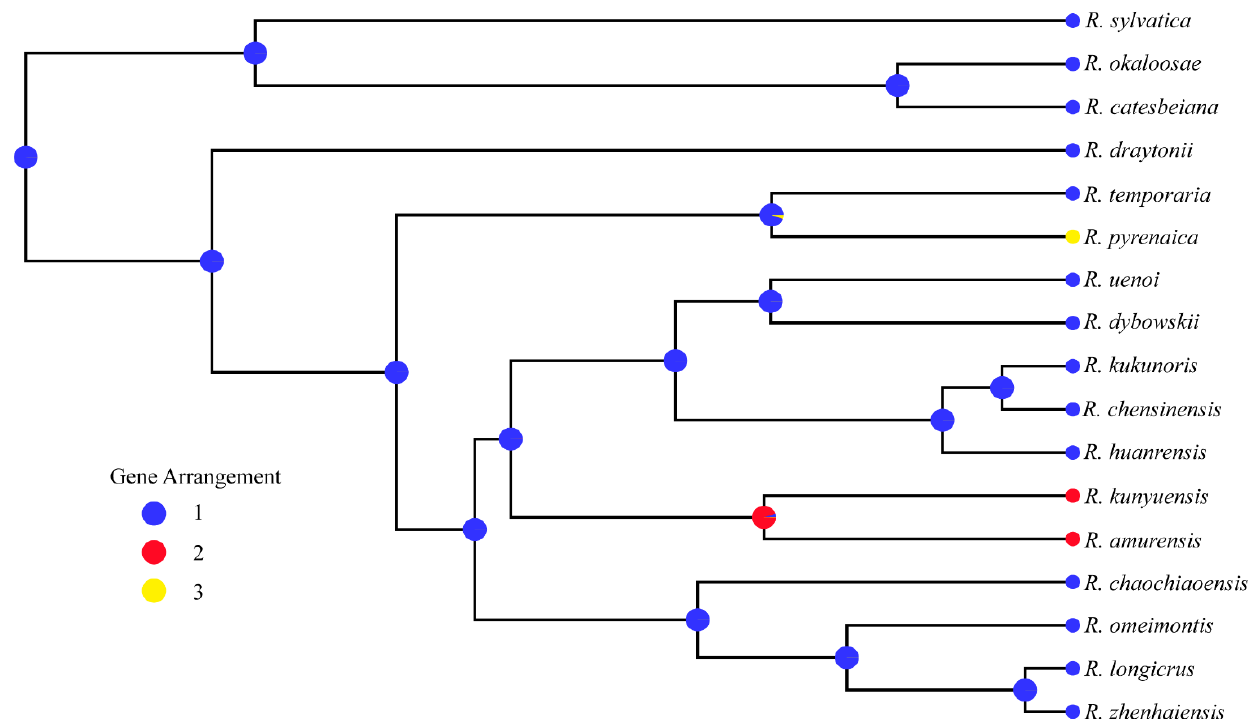
Figure 6. Reconstruction of ancestral mitogenomic rearrangement of Rana . Pie diagrams on nodes indicate the relative probability for each pattern.